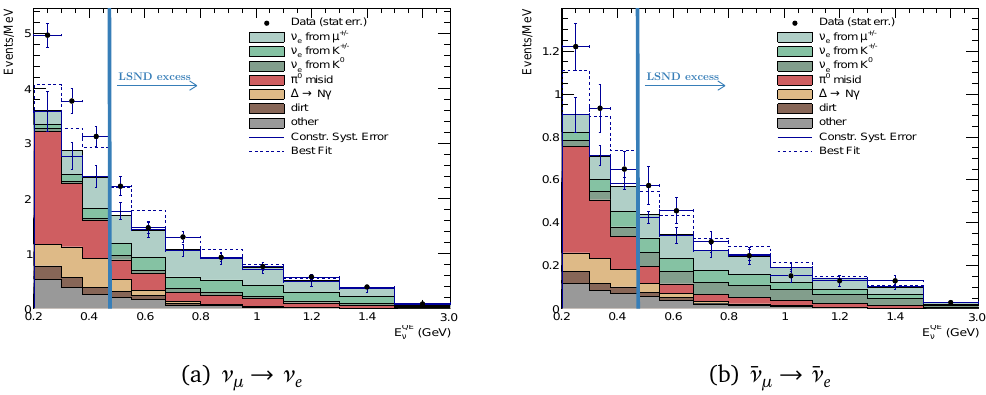
and ¯ ν channels. The backgrounds are shown e e